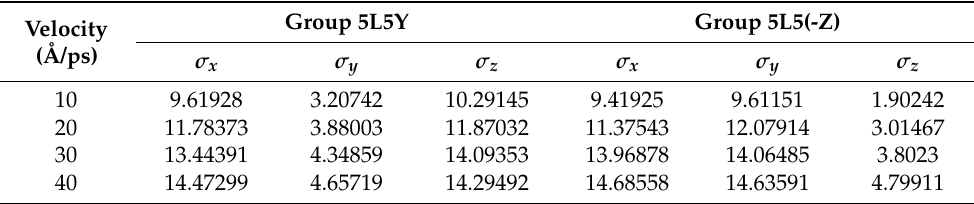
Table 5. The variance of the stress components at the ratio is